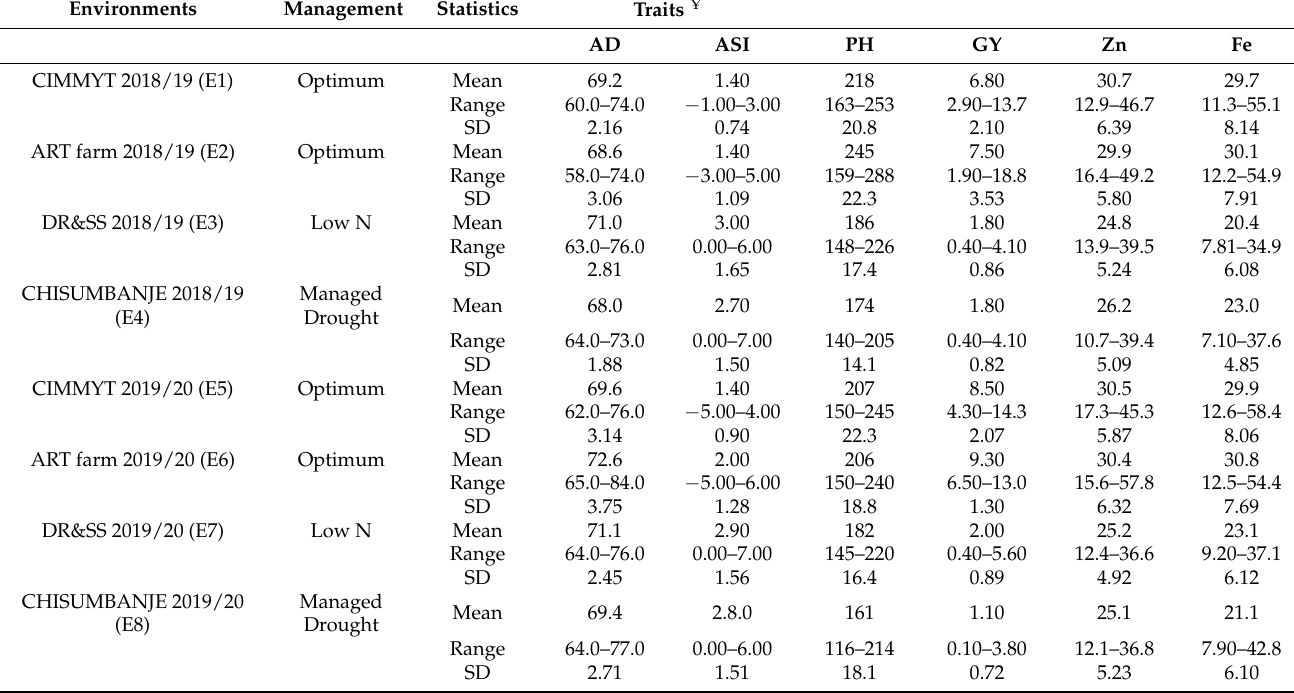
Table 2. Descriptive statistics of the performance of Zn-enhanced testcross hybrids grown under optimum, low N and managed drought conditions.